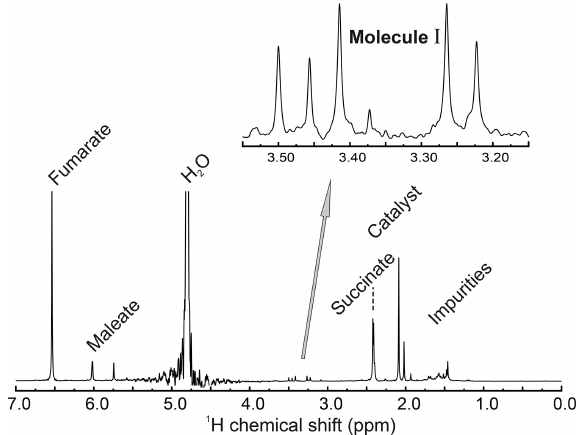
Figure A1. Full 1 H NMR spectrum (400MHz) of the reaction so- lution after hydrogenation, taken at a temperature of 298K. An ex- panded view of the methylene region is shown. This shows four peaks from the inequivalent methylene protons of the reaction prod- uct I as well as an additional peak at 3.50ppm from the achiral decomposition product of I (see Supplement). The small peak at 3.37ppm is unassigned. The spectrum shows peaks from several other substances, including fumarate, succinate, and maleate, as well as the hydrogenation catalyst.